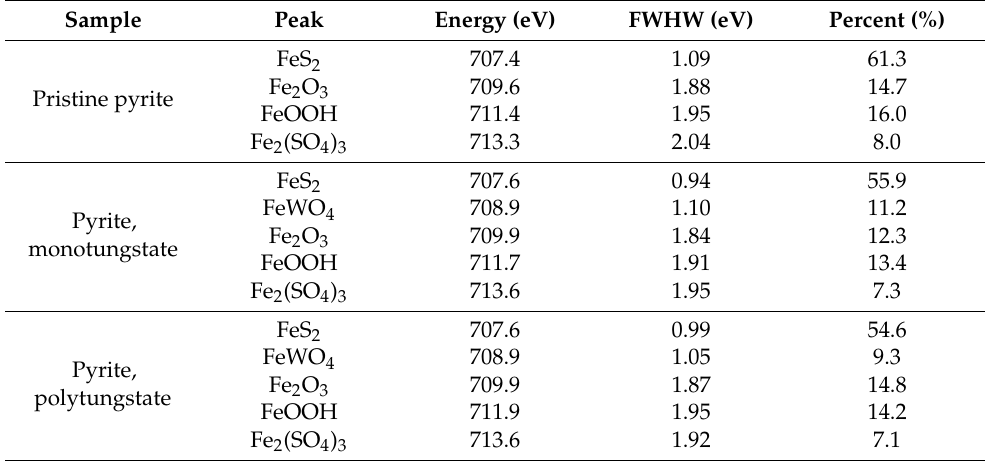
Table 6. Fitting parameters for Fe2p3/2 spectra of pristine and mono/polytungstate-loaded